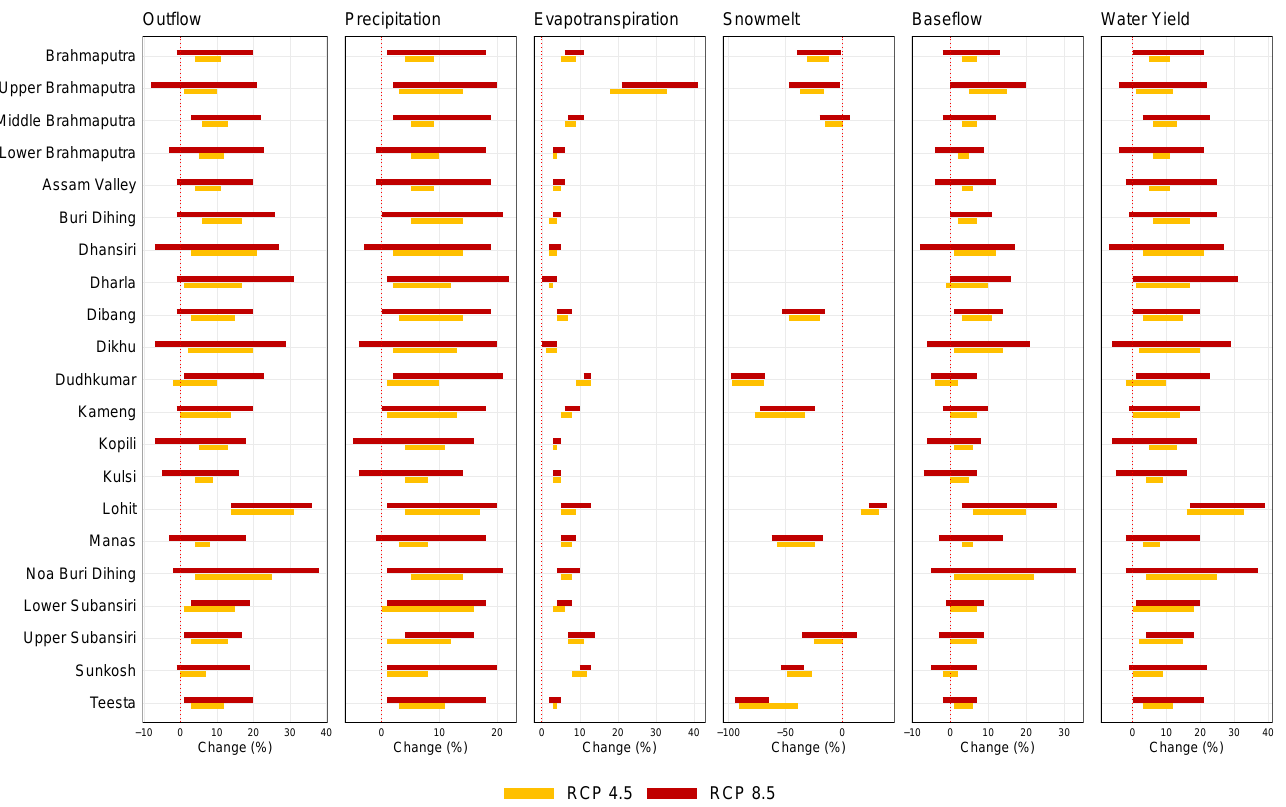
Figure 13. Annual maximum and minimum percentage changes in key water balance components for the entire Brahmaputra basin and its large subbasins under RCP4.5 and RCP8.5 scenarios. For each RCP, maximum and minimum ranges are based on four climatic